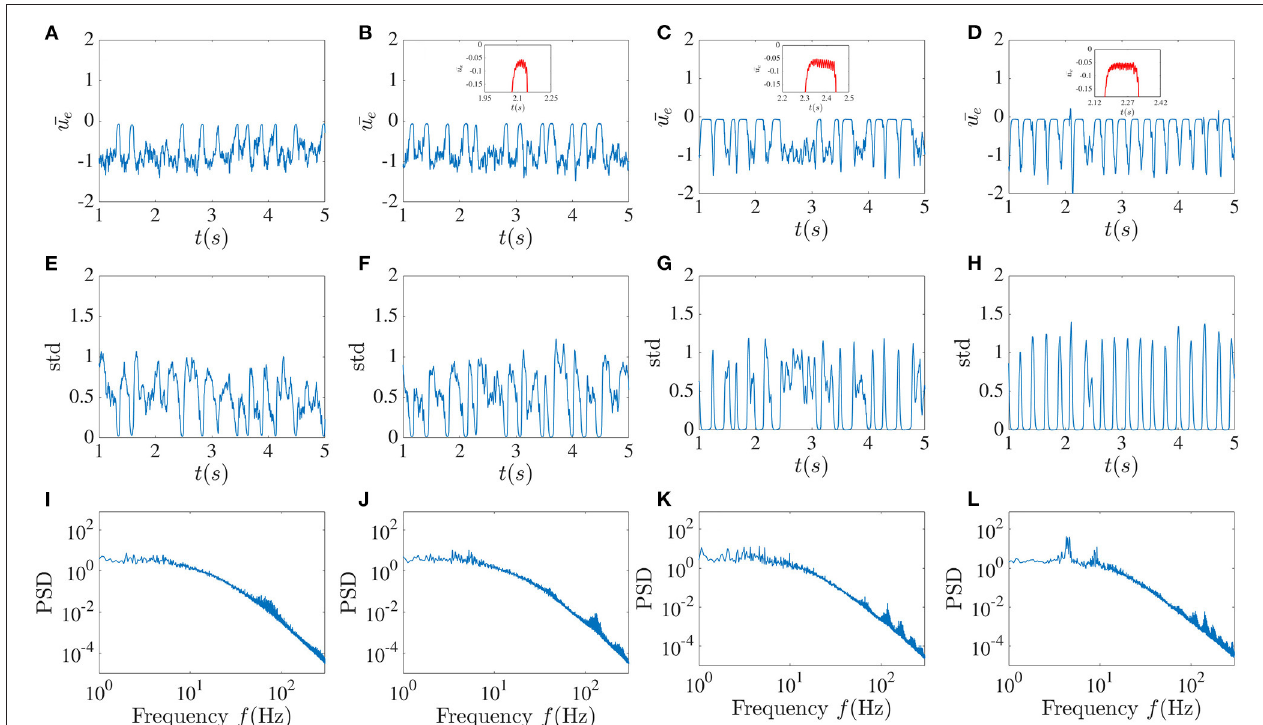
FIGURE 4 | Higher global feedback delay causes activity dropouts. Mean of the excitatory sub-network activity (A–D) , the standard deviation of the activities of its units (E–H) , and the power spectrum averaged over the units in the excitatory sub-network (I–L) in the presence of global inhibitory feedback with fixed strength κ 5 without noise. From left to right, the global feedback time delay T equals 5, 10, 20, and 30 ms. The pulse-like epochs in the solution correspond to “activity = − dropouts” where the sub-network is synchronized with a low firing probability. Paradoxically, between these dropouts, the time-dependent mean activity is lower but its time-dependent fluctuations are stronger. Insets in the figures in the first row show the high-frequency low-amplitude oscillations that occur during the dropouts. The more regular pulsing in (D) is associated with a low frequency peak and its harmonics riding on top of the broadband